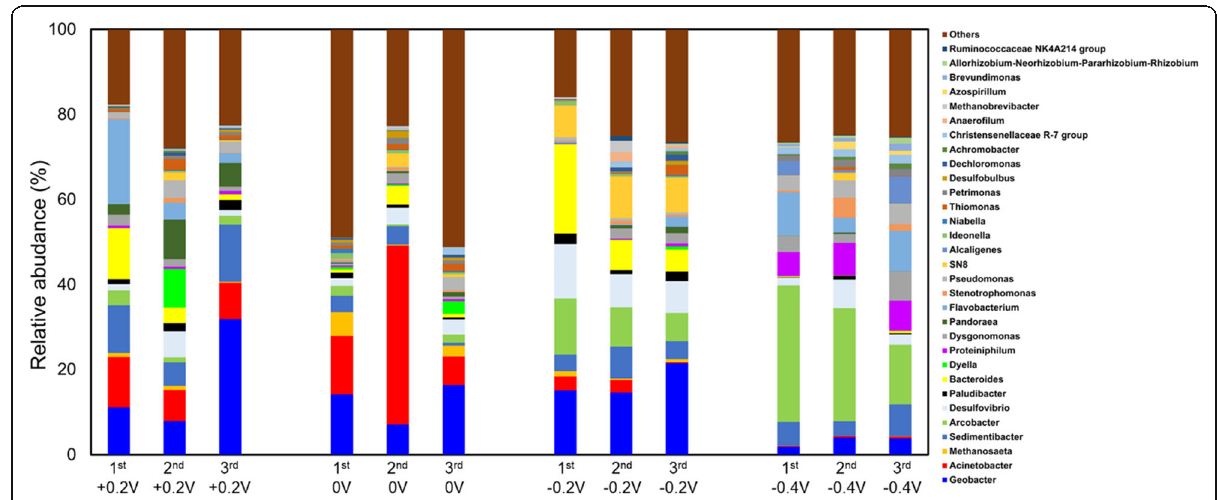
Fig. 3 Relative abundance of different genera on anodes cultivated at poised potential sampled from three substages (1 st sampling at substage 1, 2 nd sampling at substage 2, 3 rd sampling at substage 3). Unassigned and minor genera accounting for < 1% of total sequences